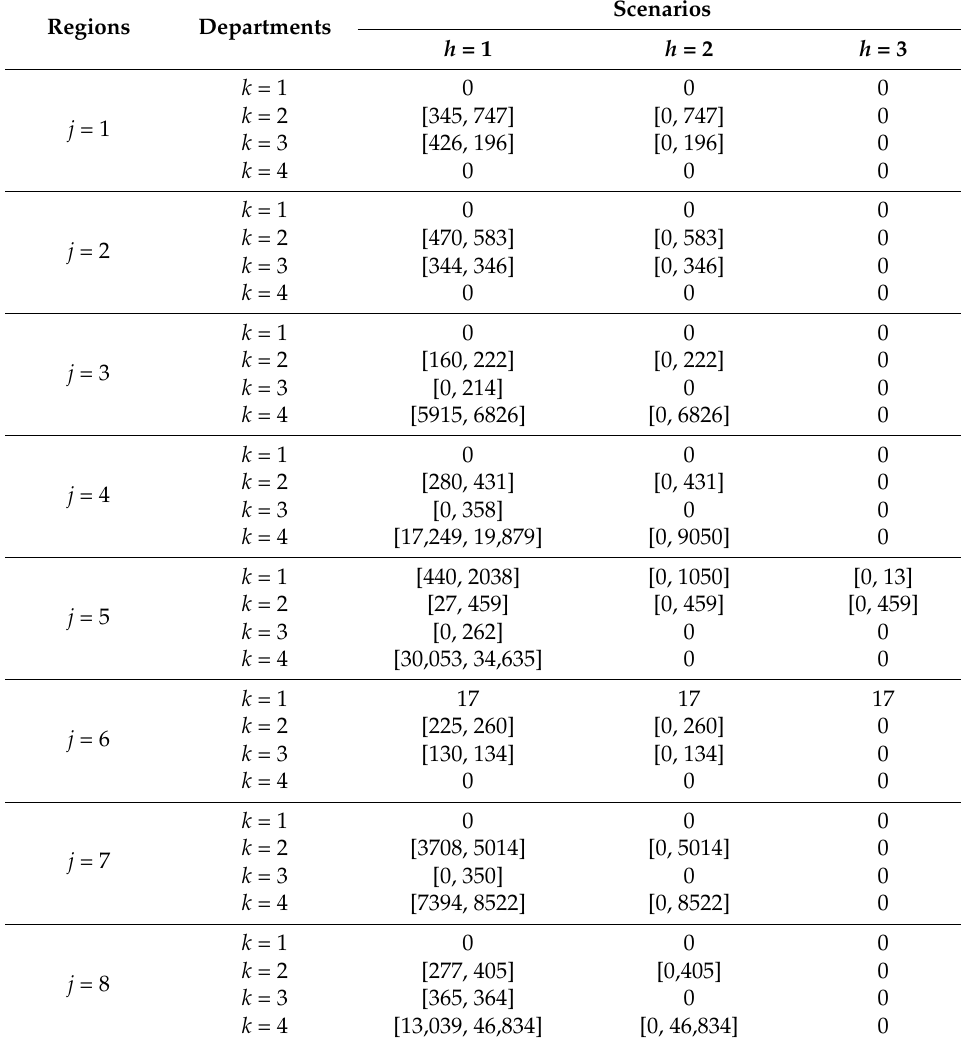
Table 5. Water resource deficit for each sector under different scenarios in Period 2 (10 4 m 3 /year).